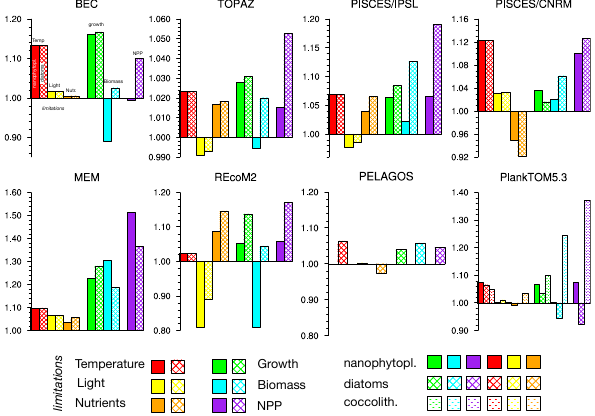
Figure 12. Relative changes between 2012–2032 and 2080–2100 in annual mean temperature limitation factor (red), light limitation fac- tor (yellow), nutrient limitation factor (orange), growth rate (green), biomass (light blue) and NPP (purple) for nanophytoplankton (full), diatoms (hatched) and coccolithophores (dotted) at the surface of the Southern Ocean (50–90 ◦ S). An increase in limitation factor denotes weaker limitation, which leads to stronger growth. PELA- GOS has a relative diatom contribution of more than 95% of total biomass; therefore we show only results for